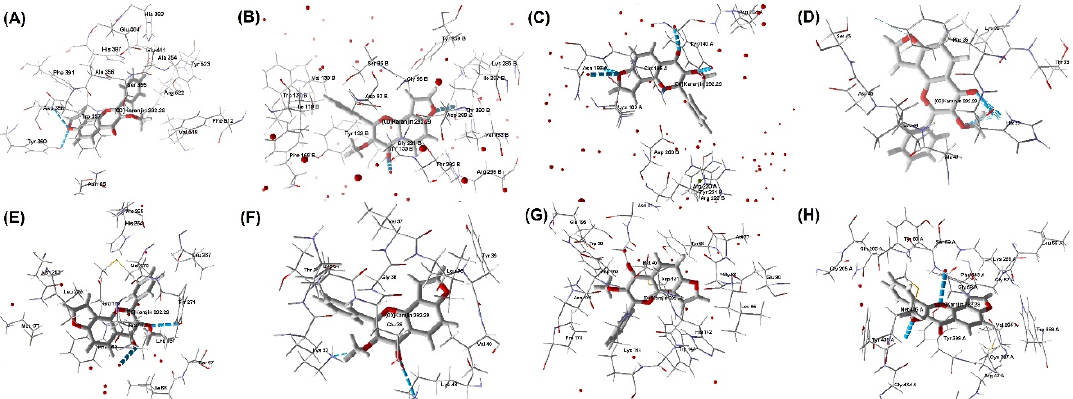
Figure 5. Molecular interactions of the natural karanjin against four putative drug targets for each AD and PD (Molegro Virtual Docker); ( A ) interaction against ACE (PBD ID: 1O86); ( B ) interaction against BACE1 (PBD ID: 4DJU); ( C ) interaction against GSK-3 (PDB ID: 1Q5K); ( D ) interaction against TACE (PDB ID: 2OI0); ( E ) interaction against A 2A AR (PDB ID: 3EML); ( F ) interaction against ASN (PDB ID: 1XQ8); ( G ) interaction against COMT (PDB ID: 1H1D); and ( H ) interaction against MAO_B (PDB ID:2C65), respectively. The Blue colored lines in the figure indicate hydrogen bond interaction.